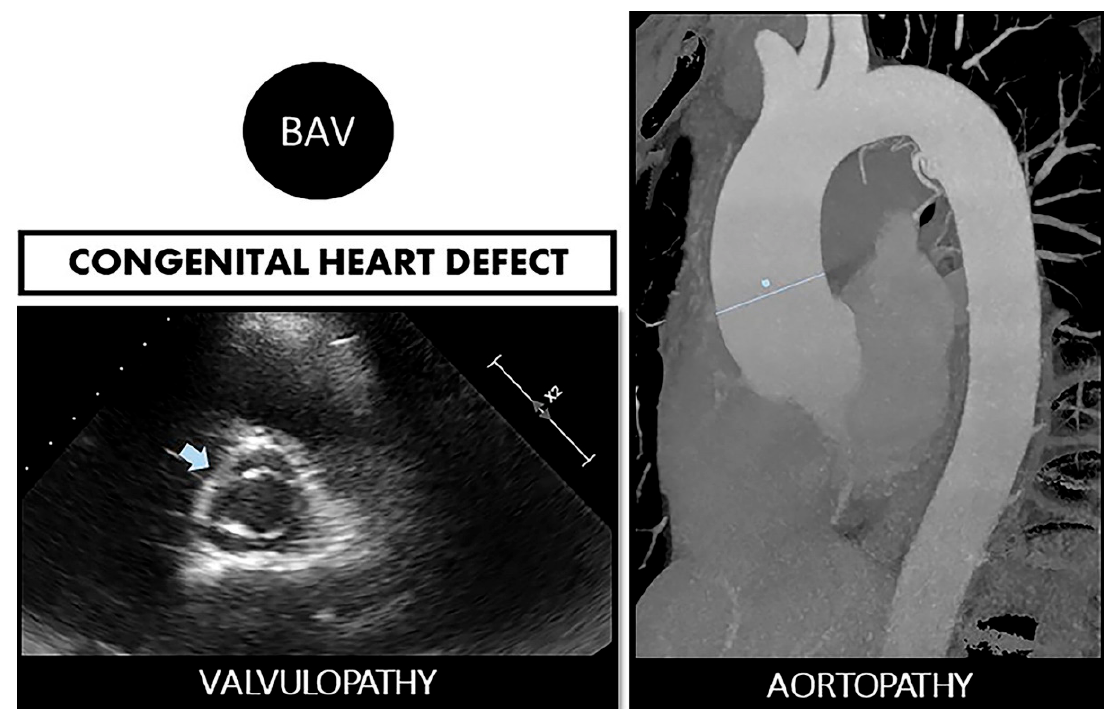
Figure 1. Bicuspid aortopathy is a double road. The congenital defect can develop in the person who suffers from both valvulopathy (stenosis or regurgitation) and aortopathy (aneurysms and risk of spontaneous dissection). On the left, echocardiographic image of BAV (arrow). On the right, a resonance image of dilated ascending aorta (marked straight line).